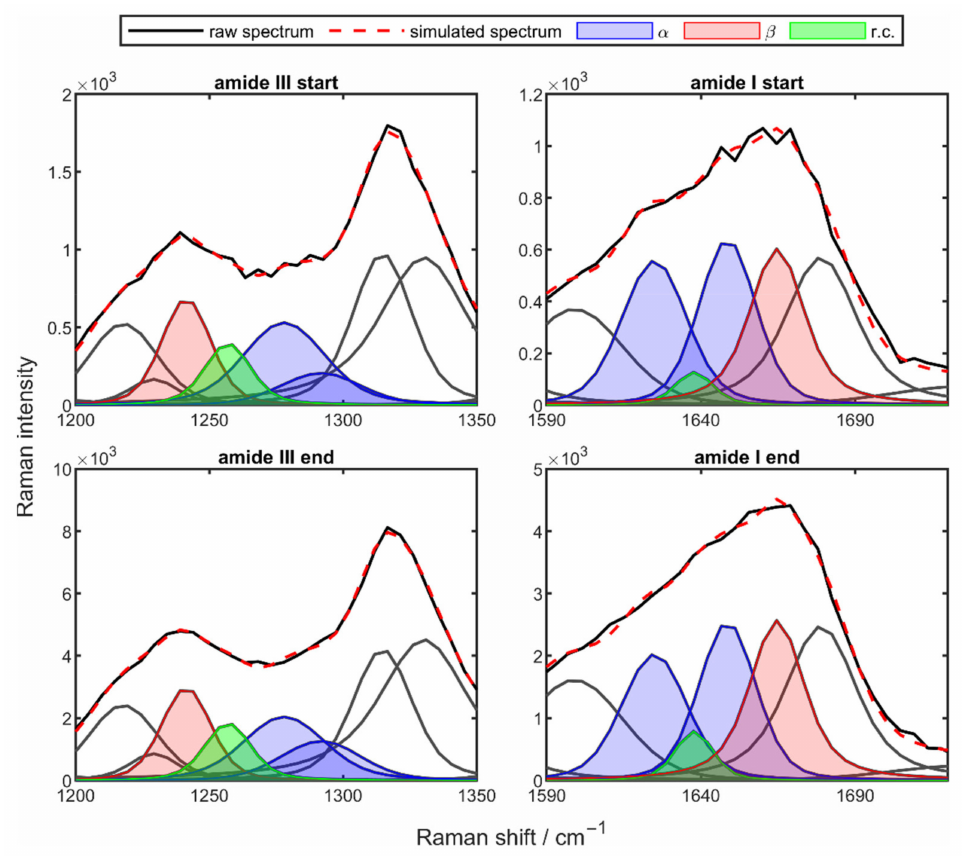
Figure 5. Amide III region ( left column ) and amide I ( right column ) of the reconstructed spectrum from the drying process of a 10 wt% poly-L-lysine solution droplet at a drying temperature of 50 ◦ C at the beginning ( top row ) and the end of the drying process ( bottom row ), with the different secondary structure elements